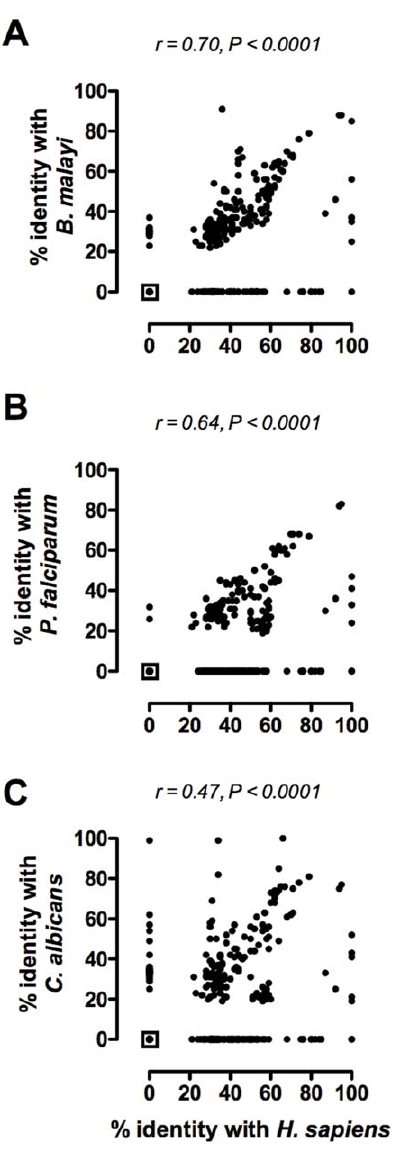
Figure 4. Allergens with homologues among microbes display similar levels of conservation with human proteins. The percent identity levels between human proteins (x-axis) a representative helminth ( B. malayi , A ), protozoan ( P. falciparum , B ) and fungus ( C. albicans , C ) protein (y-axis). Correlations were evaluated by Spearman rank test. Each dot represents one allergen and the squared-dot at the origin of the axis represents allergens that had neither homologues in humans nor in the microbes: (A) n=222, (B) n=247 and (C) n=210 allergens.